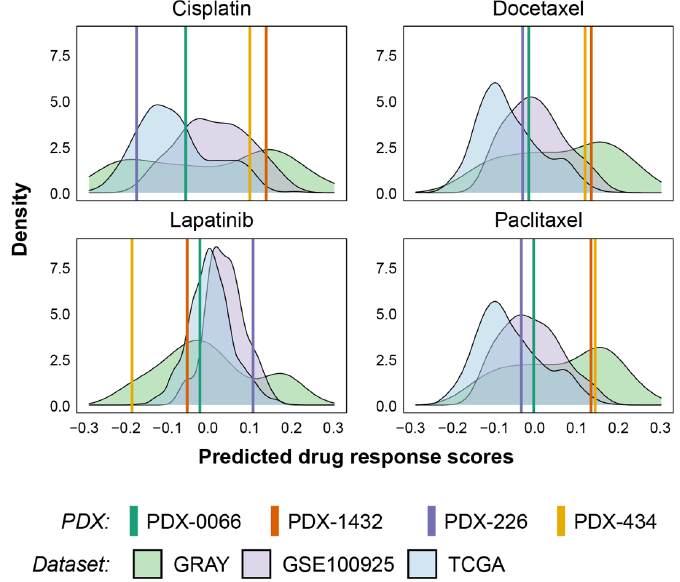
Figure 3. Dynamic range of predicted response in PDX tumors is comparable to that from publicly available datasets. Drug efficacy scores computed for the PDX tumors and publicly available patient and cell line datasets using stingscore, exhibit a wide range of predicted responses. Bimodal distributions are noticeable in most plots, highlighting the presence of responsive and resistant populations within each dataset.